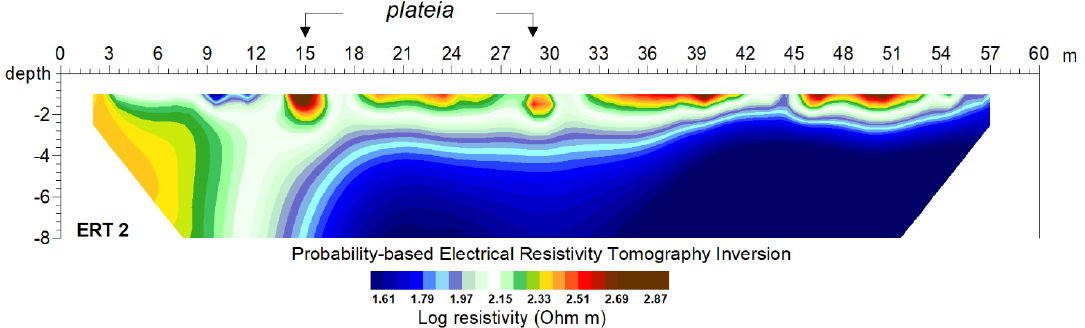
Figure 13. ERT 2, line 2 in Figures 3 and 11.